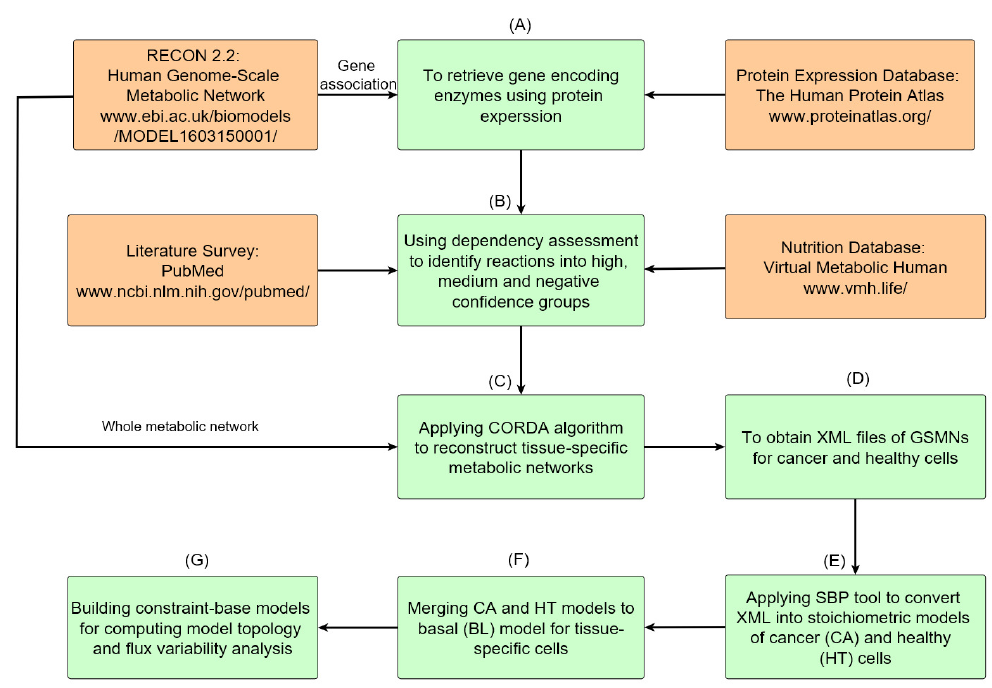
Figure 1. Roadmap of reconstruction of genome-scale metabolic networks for normal and cancer tissues. ( A ) Protein expressions of normal and cancerous colorectal tissues are accessed from HPA, and gene encoding enzymes are obtained through the gene association of Recon 2.2. ( B ) The acquired data are used to determine high, medium, and negative confidence sets of reactions. ( C ) The metabolic networks of cancer and healthy cells for the colorectal tissue are reconstructed using the CORDA algorithm. ( D ) Metabolic networks are stored in XML format. ( E ) The SBP tool is used to transfer metabolic networks to their stoichiometric models and gene-protein-reaction models. ( F ) Both cancer and healthy models are merged into a basal model. ( G ) The basal model can be used for further analysis and